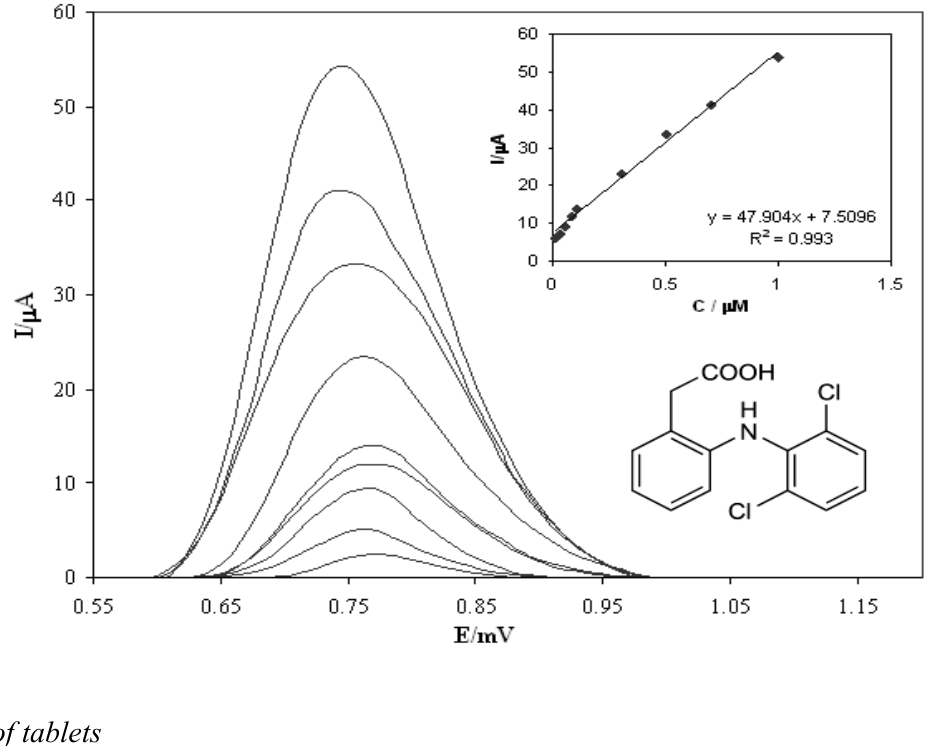
9. Adsorptive square wave voltammograms obtained for the increasing concentration of diclofenac in acetate buffer (pH = 4) (a-k) at concentration (1, 0.7, 0.5, 0.3, 0.1, 0.08, 0.05, 0.03, 0.02 and 0.01  M) respectively. Intercept: dependence of